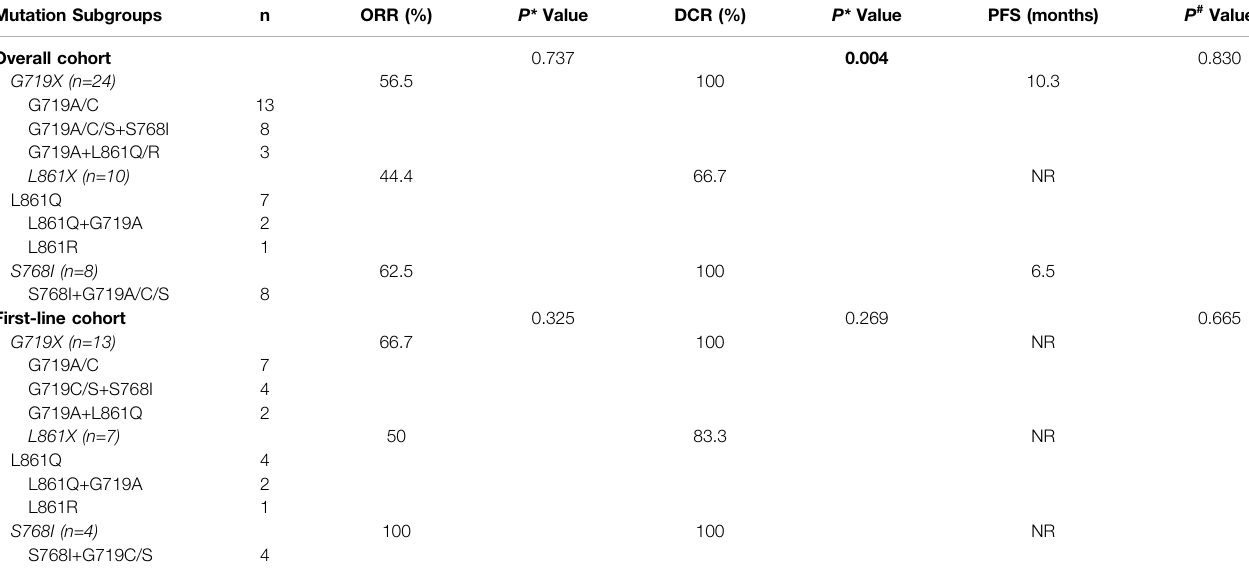
TABLE 2 | Treatment responses and prognosis of different mutation subgroups. Mutation